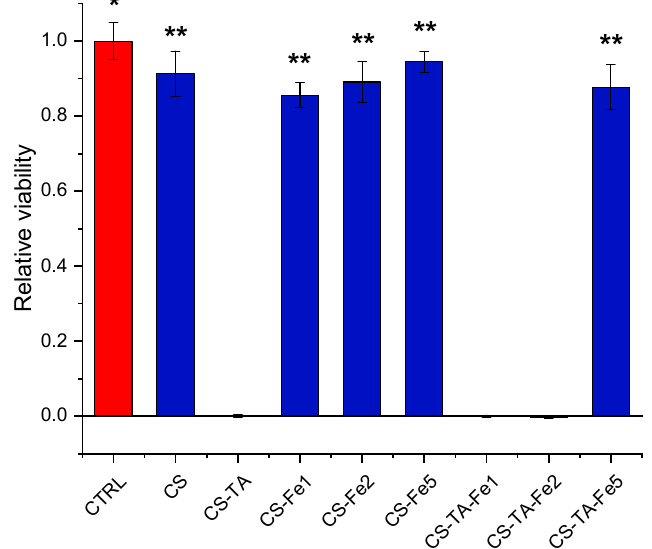
Figure 6. Indirect cytotoxicity assay performed with film extracts using standard culture medium as control (CTRL). The graphic shows the mean fluorescence ± SD recorded from HDFs treated with the different experimental conditions. Results have been normalized against the CTRL condition. * p ˂ 0.001 vs. CS-TA, CS-TA-Fe1 and CS-TA-Fe2; p ˂ 0.05 vs. CS-Fe1; ** p ˂ 0.001 vs. CS-TA, CS-TA- Fe1 and CS-TA-Fe2.